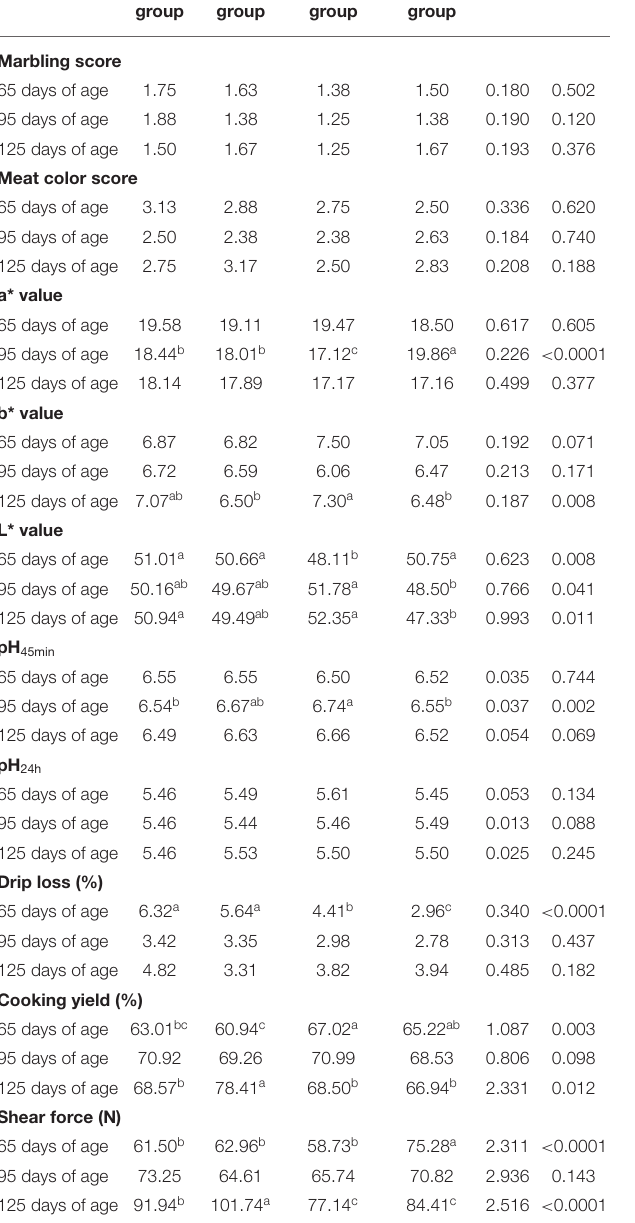
TABLE 4 | Effects of probiotics and synbiotics addition in sows’ diets on crude protein and amino acid contents in the longissimus thoracis muscle of offspring pigs (g/100g fresh